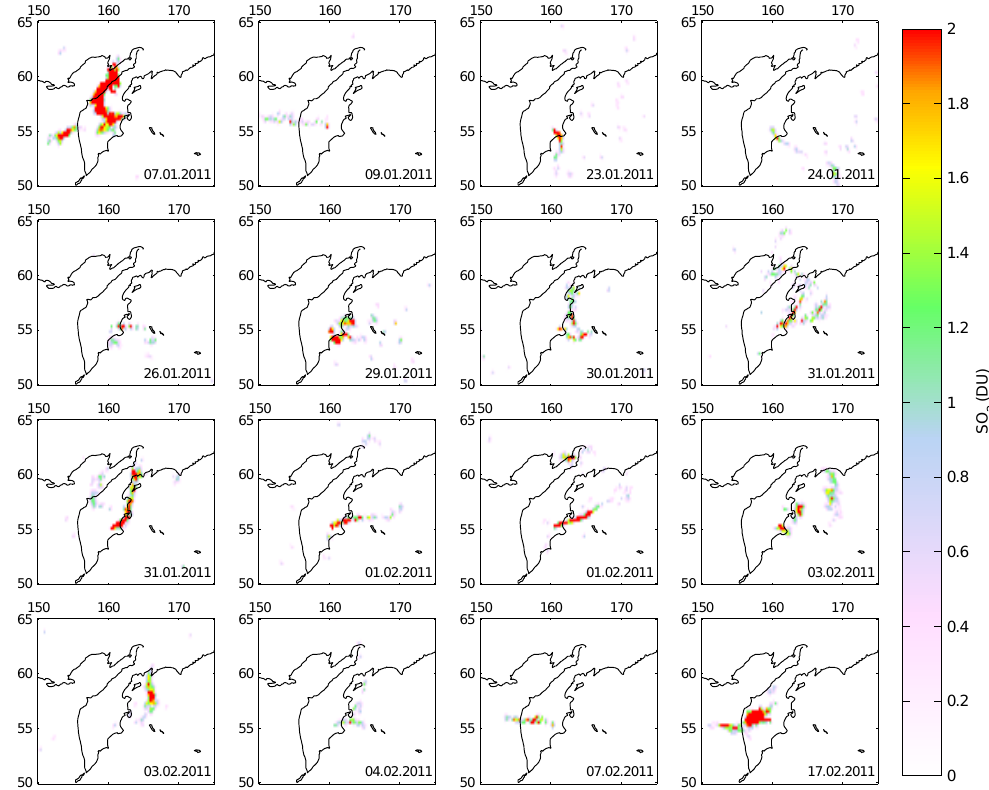
Fig. 13. Snapshots of volcanic SO 2 plumes detected in the first part of 2011 over the Kamchatka Peninsula.